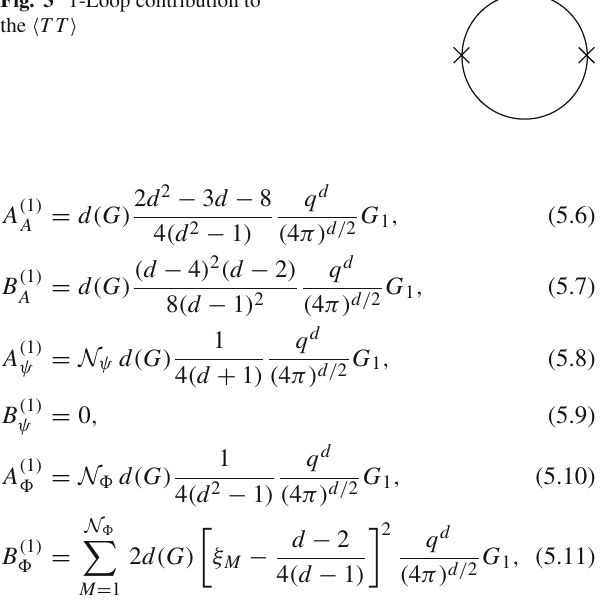
Fig. 3 1-Loop contribution